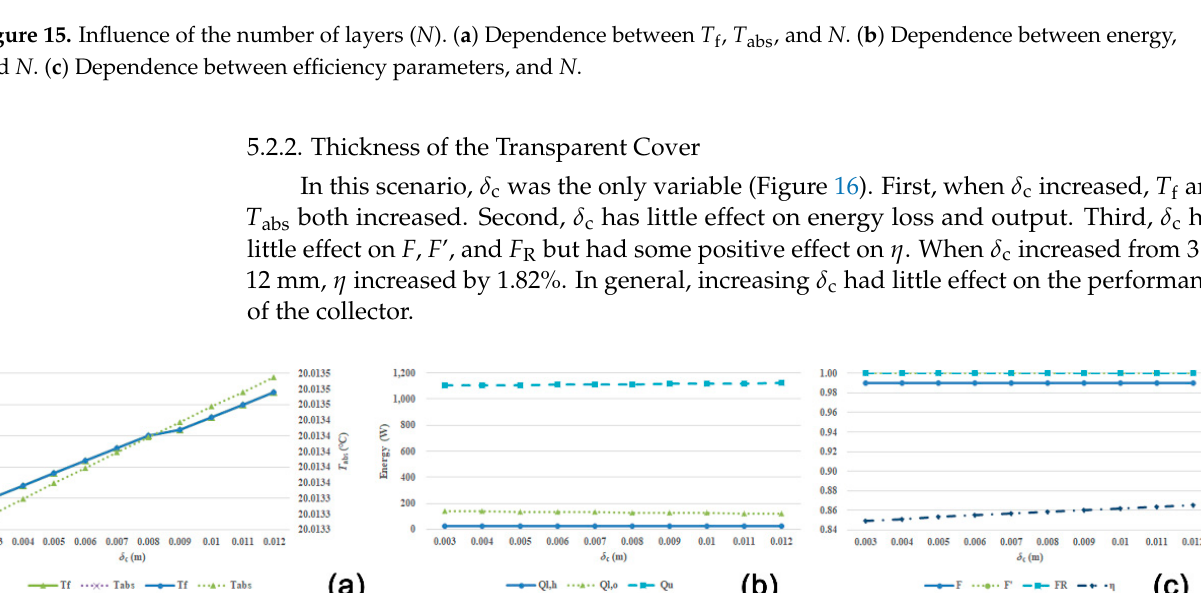
Figure 16. Influence of the transparent cover thickness ( δ c ). ( a ) Dependence between T f , T abs , and δ c . ( b ) Dependence between energy, and δ c . ( c ) Dependence between efficiency parameters, and δ c .